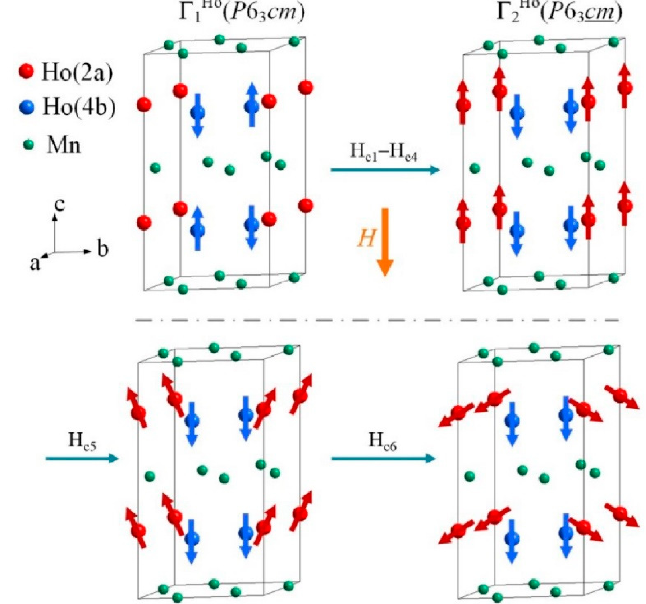
Figure 5. Proposed magnetic structures of the Ho 3+ 2 a and 4 b lattices in applied c -axis magnetic fields. The Mn 3+ spins are not shown because they strictly lie in the ab plane.